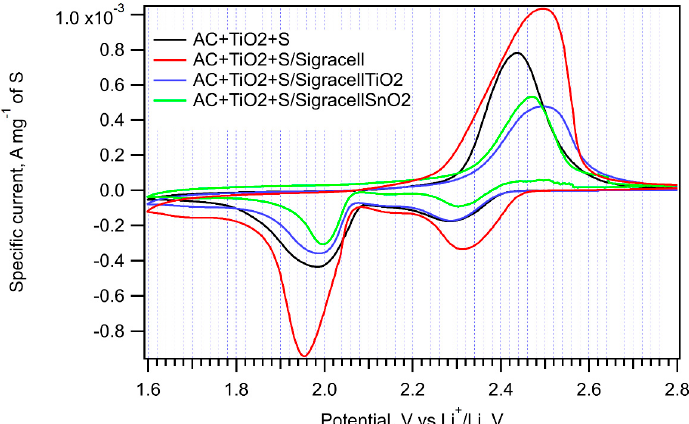
Figure 8. Cyclic voltammograms of EC + S and AC + S samples in cells without an interlayer (black curve) with the parent Sigracell interlayer (red curve) and with the Sigracell interlayer modified by metal oxide (TiO 2 -blue curve, SnO 2 -green curve) recorded with a scan rate of 0.1 mV s − 1 .